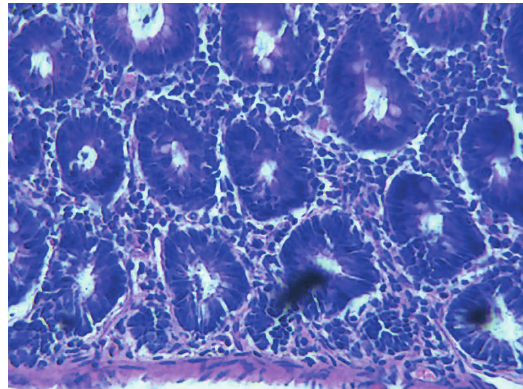
6e High dose group Figure 6e: High dose group.